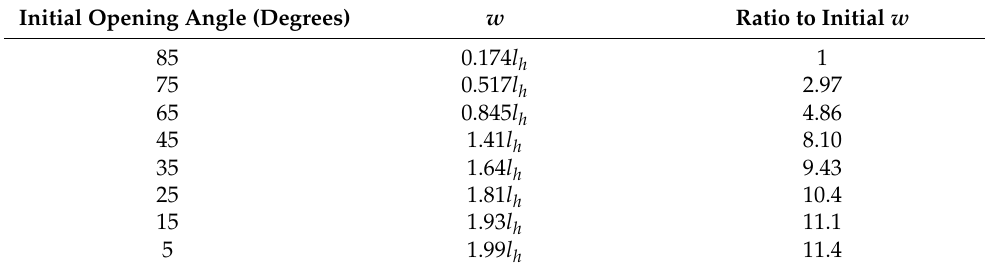
Table 4. Stretch factors for selected opening